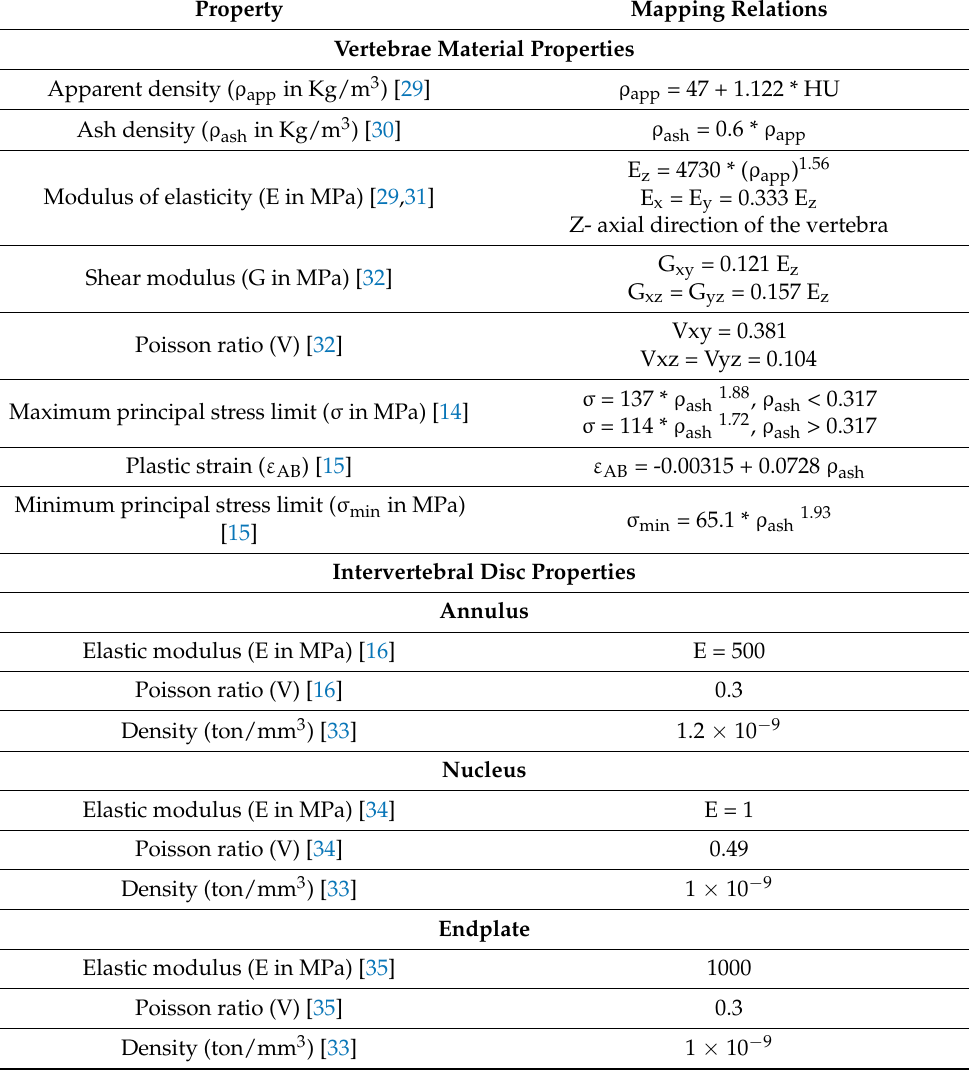
Table 1. Image-intensity-based material mapping relations for the vertebrae and material properties for the intervertebral disk used in the current finite element study.